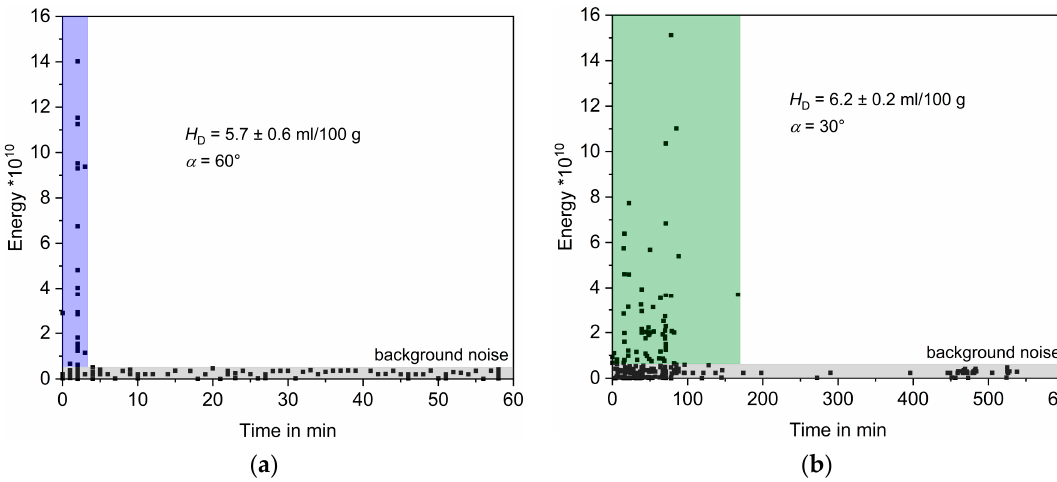
Figure 10. Acoustic emission signals during cooling starting 2 min after welding: ( a ) α = 60°; ( b ) α = 30°; shielding gas used was gas mixture containing 0.5% H 2 .